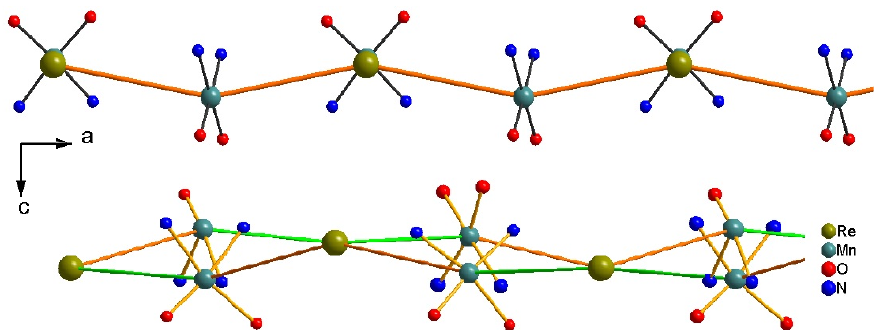
Figure 3. Schematic presentation of the anionic layer of 2 (top) and 1 (bottom), projection along the b -axis. The Re-CN apical —{MnN 2 O 2 } and Re-CN equatorial —{MnN 2 O 2 } connections are colored in green and orange, respectively.